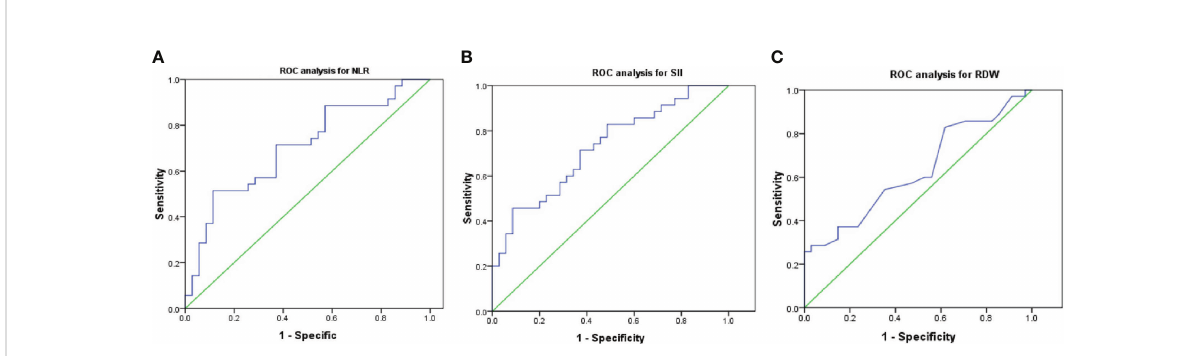
FIGURE 2 Optimal cut-off values and ROC analyses for NLR (A) , SII (B) and RDW (C) . NLR, neutrophil/lymphocyte ratio; SII, systemic immune-in fl ammation index; RDW, red cell distribution; ROC, receiver operating characteristic.